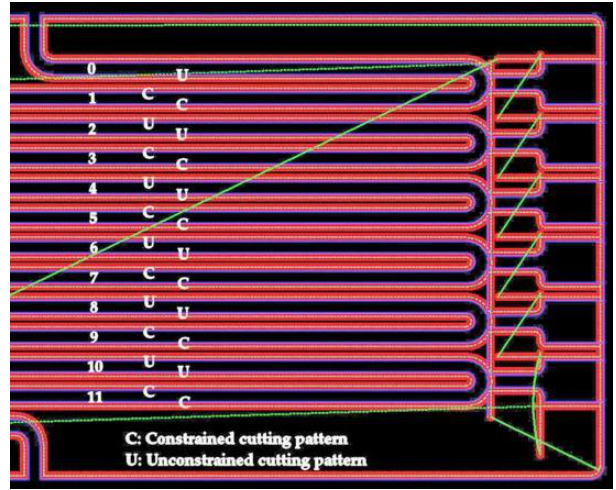
Figure 17. Tool path for the C-C and U-U cutting mode.